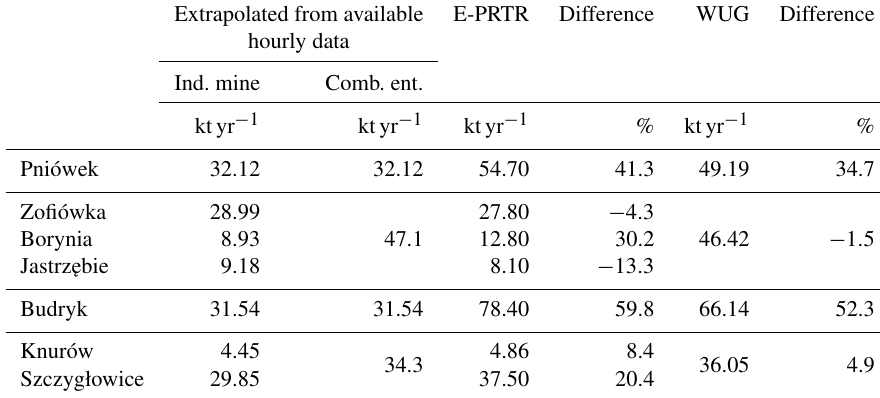
Table 4. Comparison of annual emissions of methane extrapolated using available temporal data, aggregated from individual shaft data to the level of individual coal mines (for comparison against the E-PRTR inventory) or combined entities (for comparison against the WUG). Differences against reported values are also given. Extrapolated from available E-PRTR Difference WUG Difference hourly data Ind. mine Comb. ent.